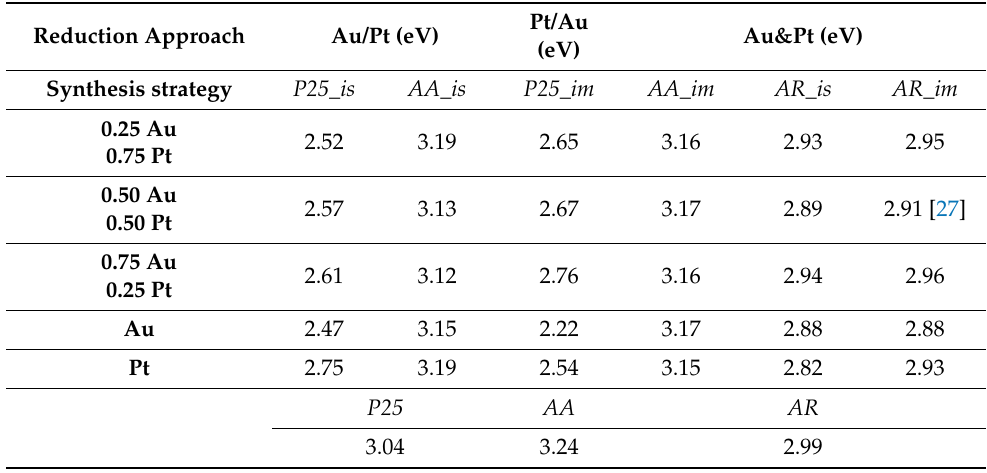
Table 1. The bandgap energies of the prepared composites